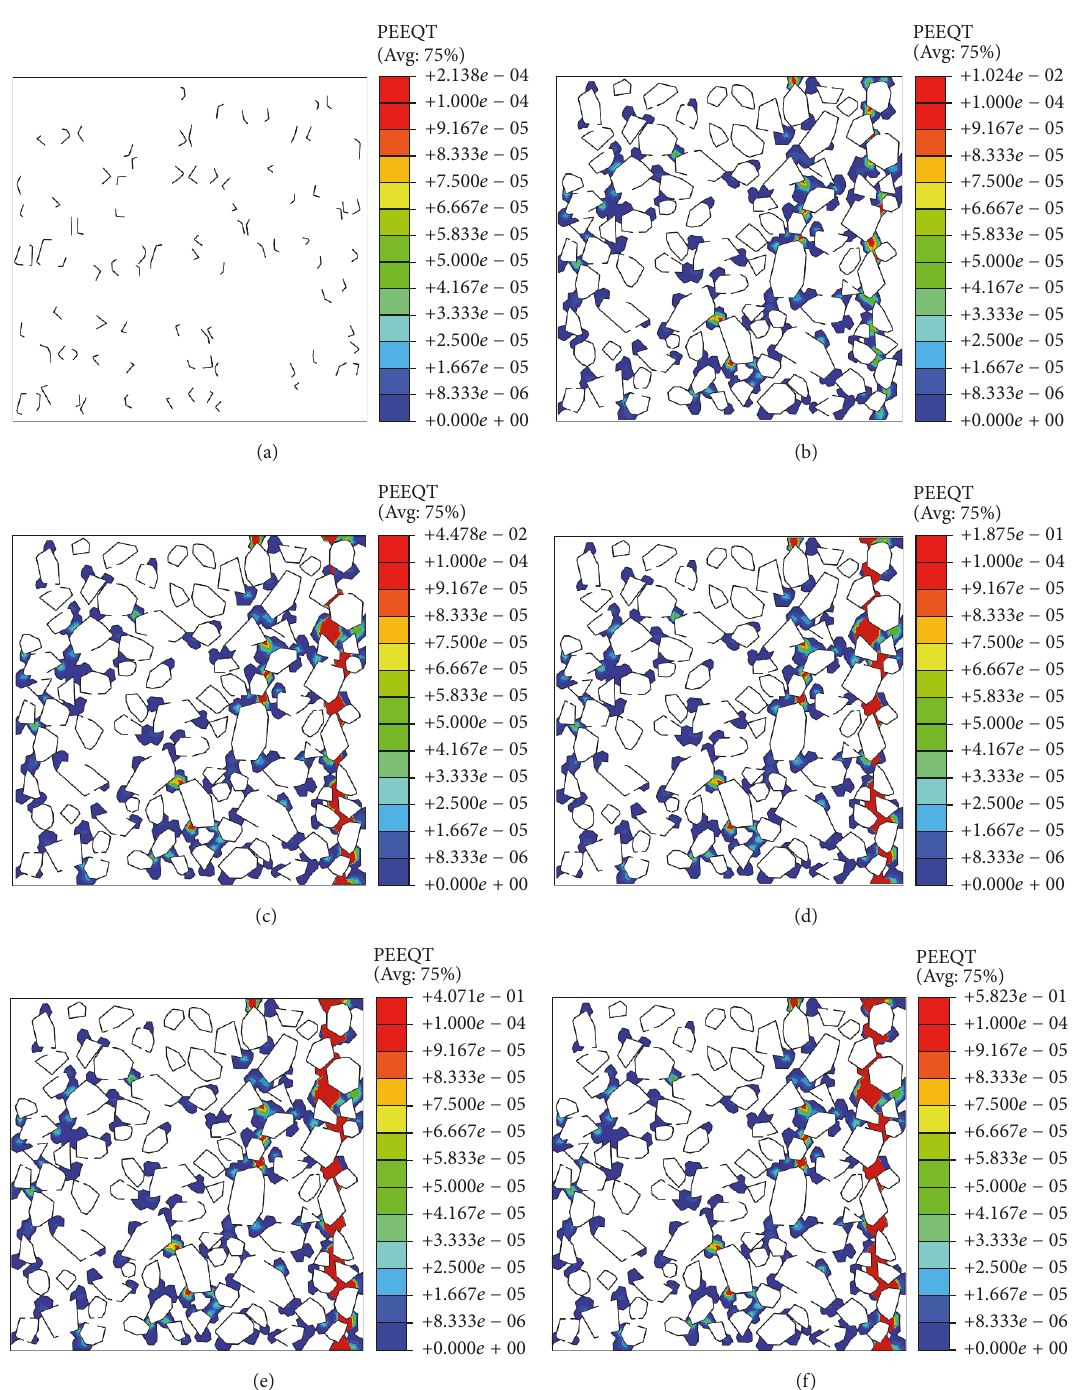
Figure 8: Mesoscale cracking development at different loading levels of the concrete specimen without void (𝐴 𝐹 = 40 %). (a), (b), (c), (d), (e), and (f) show the equivalent tensile plastic strain distributions at points a–f, respectively.